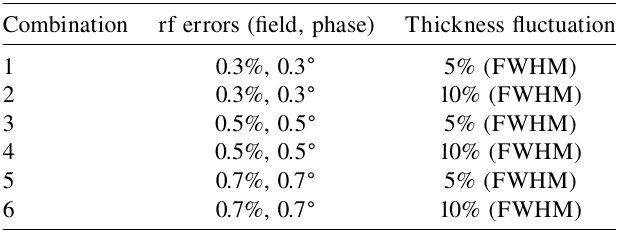
TABLE II. Combinations of rf errors and stripper thickness fluctuations used to study beam dynamics and beam losses for both the baseline and triple-spoke designs of the driver linac. Other errors are kept unchanged at the values given in Table I.